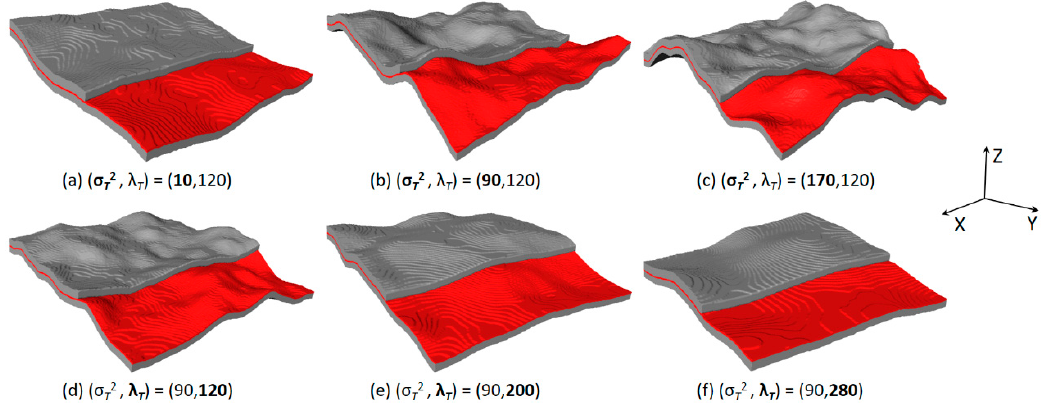
Figure 7. With fixed σ b2 = 0 and λ = ∞ , ( a–c ) demonstrate the influence of the trend surface of various σ T2 but the same λ T ; ( d–f ) show the influence of the trend surface of various λ T but the same σ T2 . The modelling trend surfaces are in red.